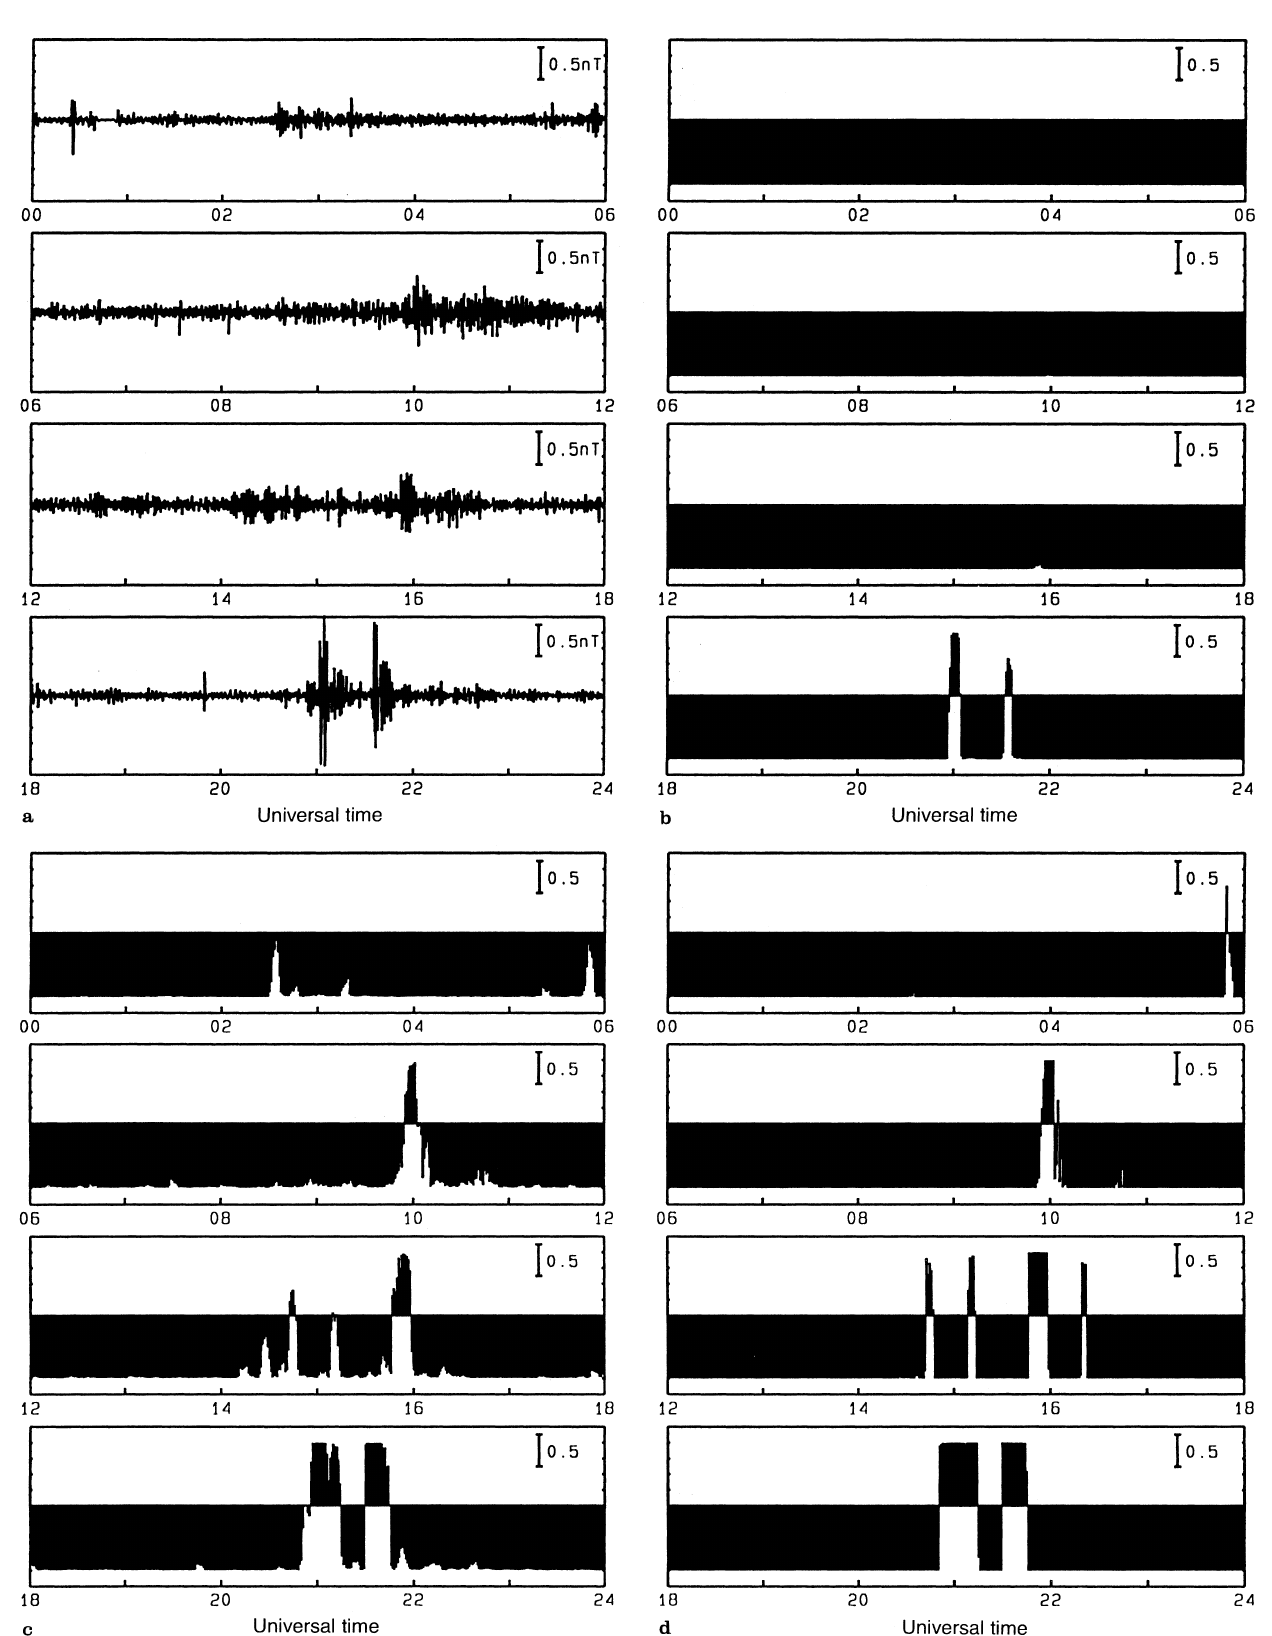
Fig. 5. a Example of a 24-h interval of induction magnetometer data. The sequences of output values for the ANNs trained using b 4 events, c 10 events, and d 100 events are also shown